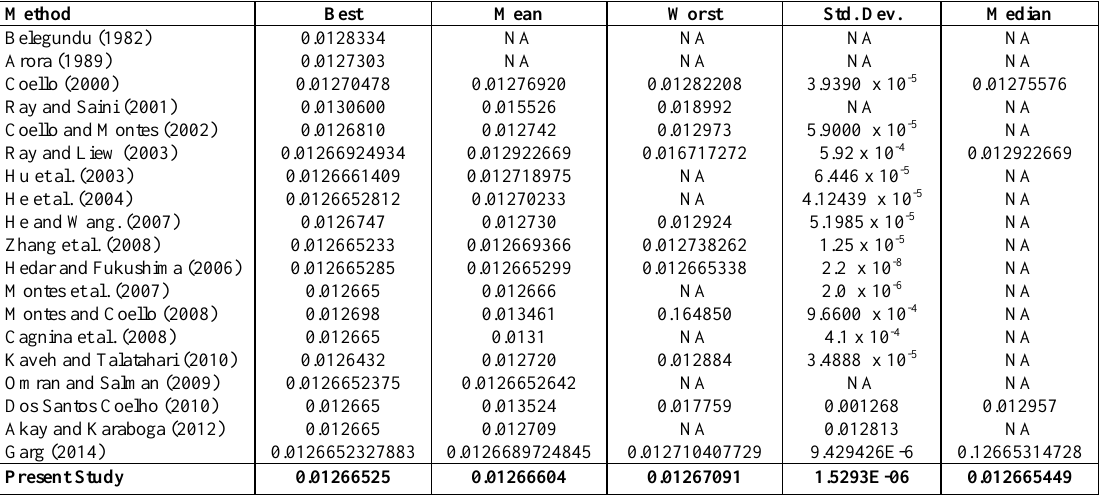
Table 6. Statistical results of different methods for tension / compression string problem (NA means not